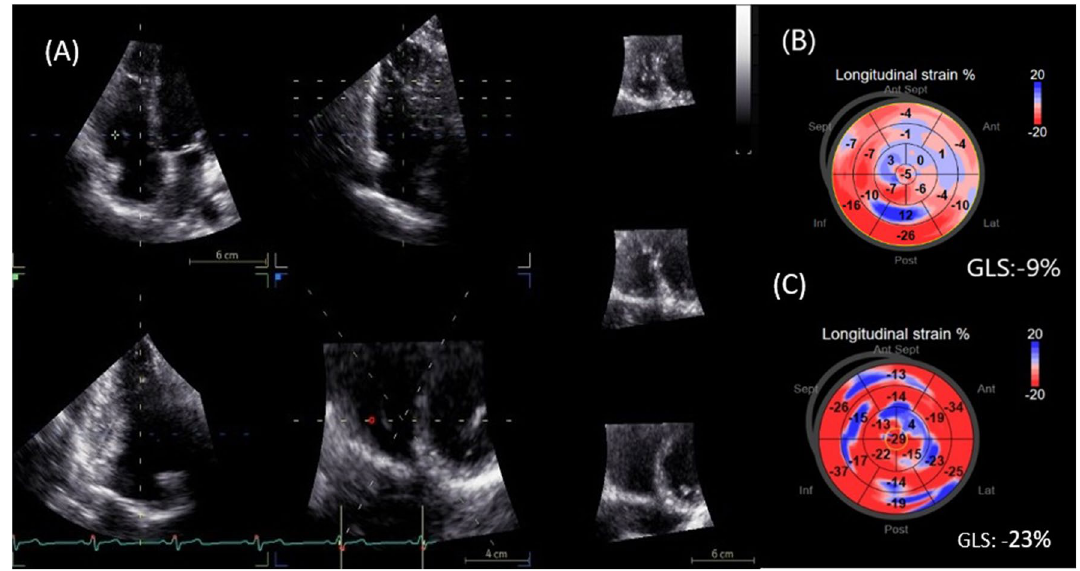
Figure 2. Representative RV 3D-STE analysis in two patients with OSA. ( A ) Automatic RV 3D-STE analysis using 4DAutoLVQ function. ( B ) Bull’s eyes reconstruction of 3D GLS in a patient with severe OSA ( decrease of GLS = − 9%) respectively, in a healthy volunteer ( GLS = − 23%). RV, right ventricle; 3D, three-dimensional; STE, speckle-tracking echocardiography; OSA, obstructive sleep apnea; GLS, global longitudinal